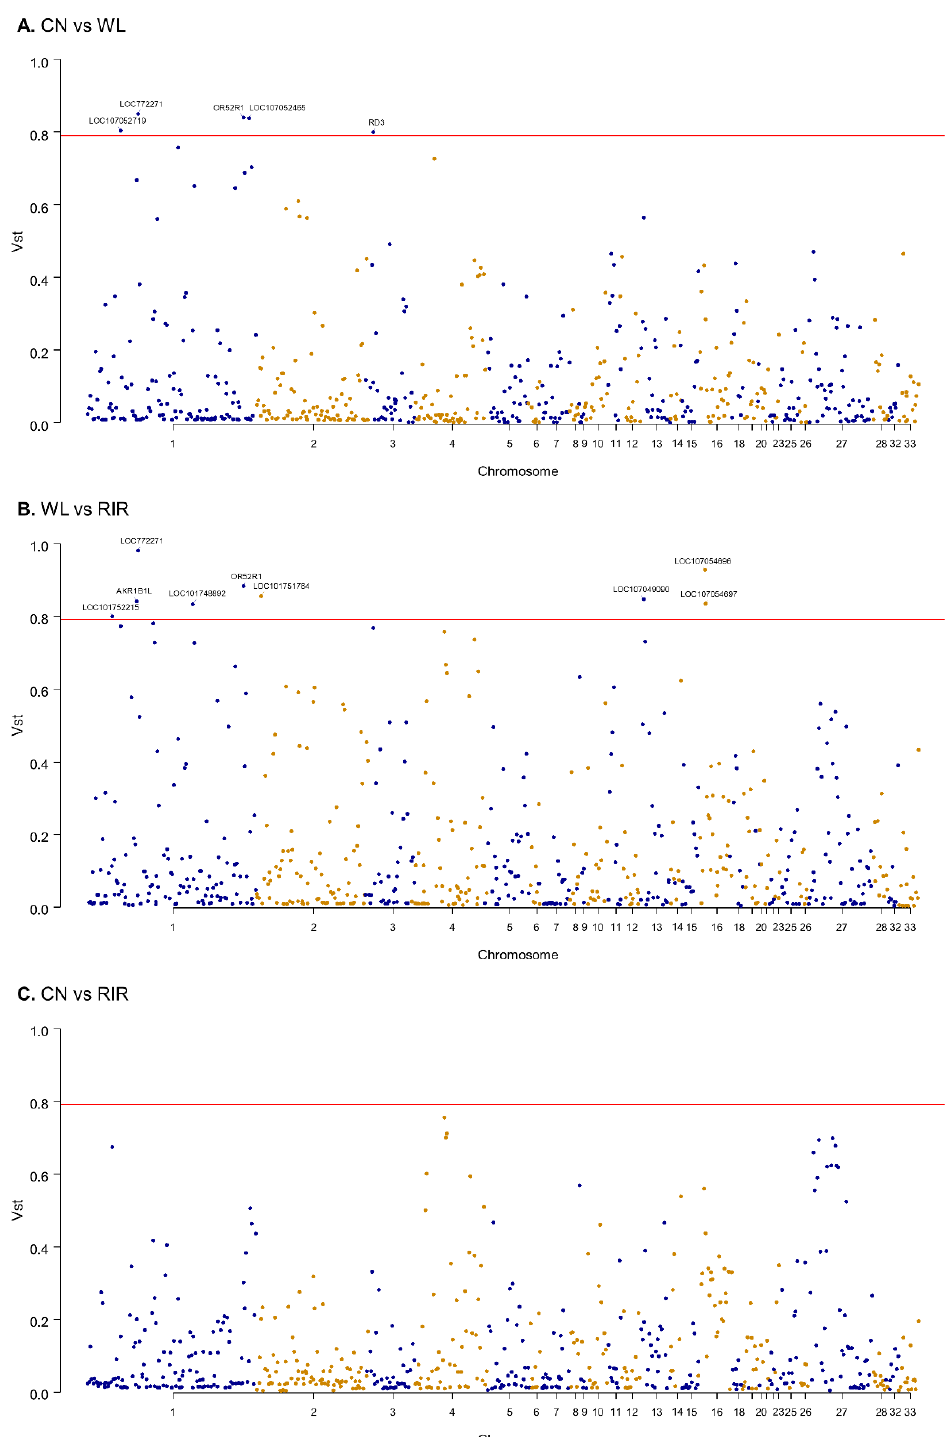
Figure 3. Manhattan plot of genome-wide genes’ V ST value. ( A ) CN vs. WL; ( B ) WL vs. RIR; ( C ) CN vs. RIR. The red line represents 0.79 V ST .